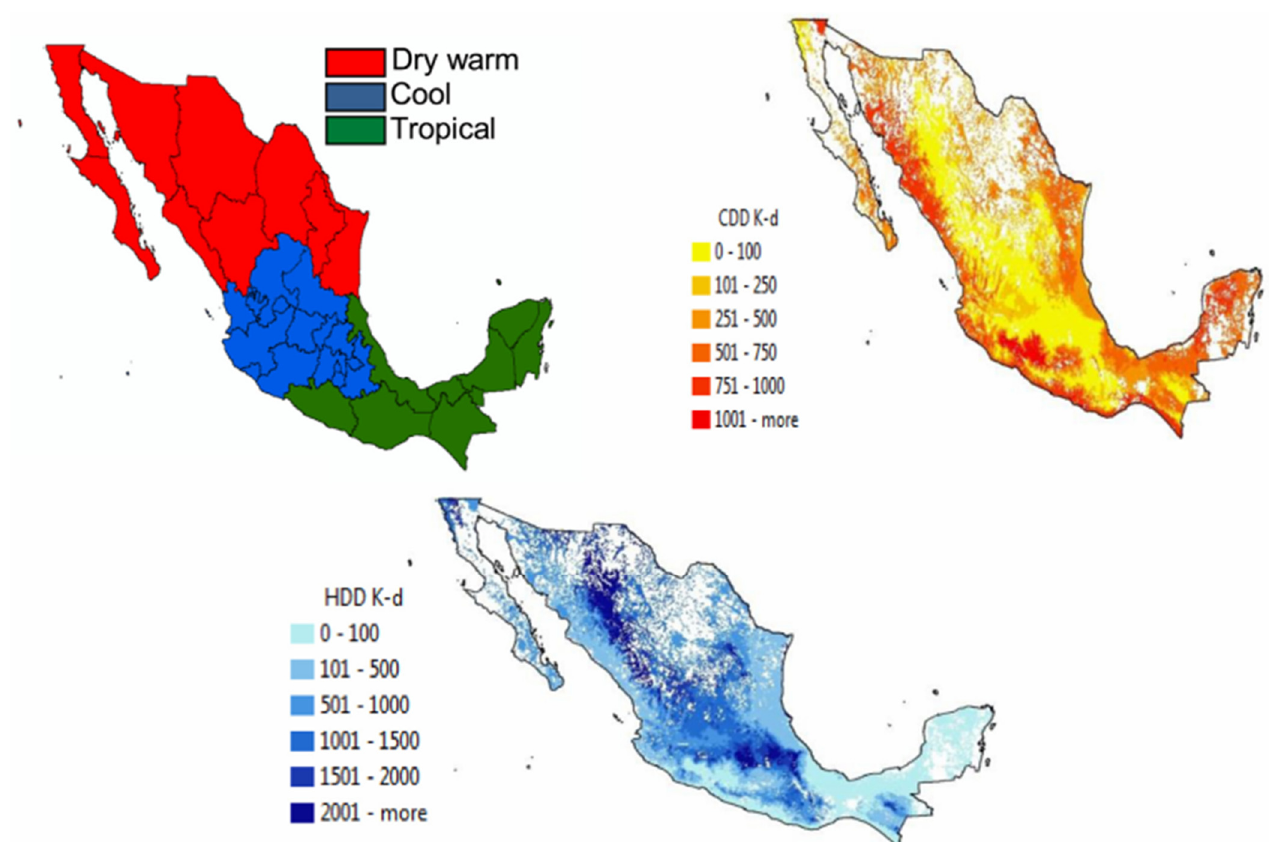
Figure 11. Mexican climatic zones [14].